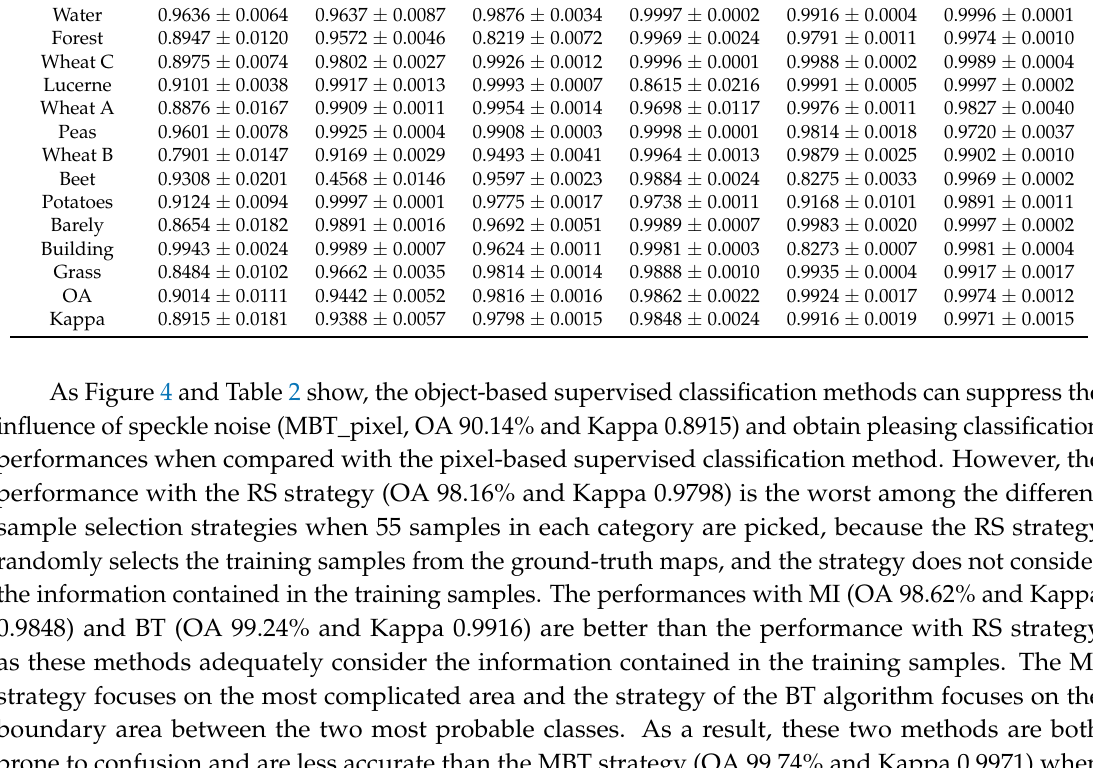
Table 2. The classification results obtained for the AIRSAR imagery with different strategies.